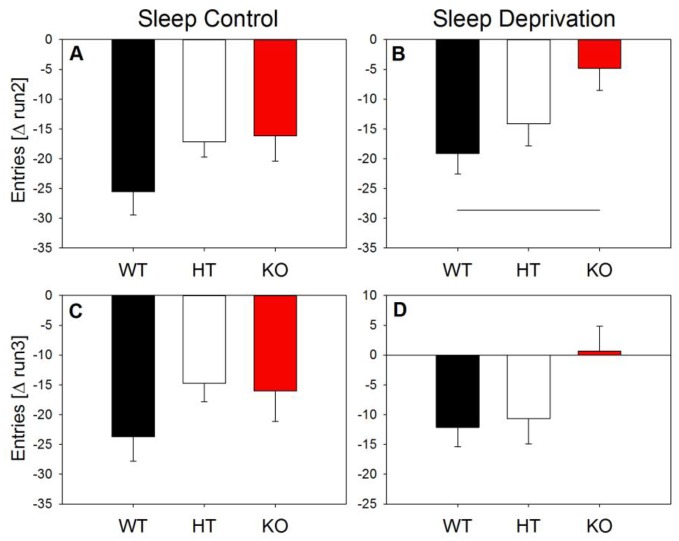
Change of exploratory activity across trials.Number of entries relative to the first maze exposure. The observed overall genotype effect (Figure 7) is restricted to the sleep deprivation condition. Main effect of ‘genotype’ in one-way ANOVA: control condition: Δrun2 and Δrun3: F2,17 > 2, pall > 0.1; sleep deprivation condition: Δrun2: F2,23 = 3.8, p < 0.04; Δrun3: F2,23 = 3.1, p = 0.06. the horizontal line indicates the significant difference between WT and KO animals (p < 0.05; Holm-corrected t-test).